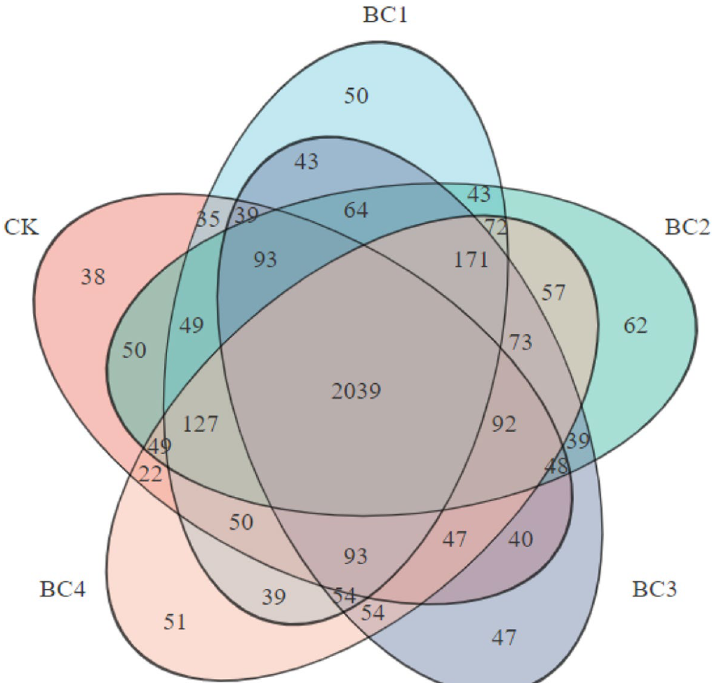
Fig. 1 Venn diagram of the OTUs of soils bacterial communities from each treatment: CK, BC1, BC2, BC3, and BC4, in which the biochar dosages were 0%, 0.5%, 1%, 2%, and 4%